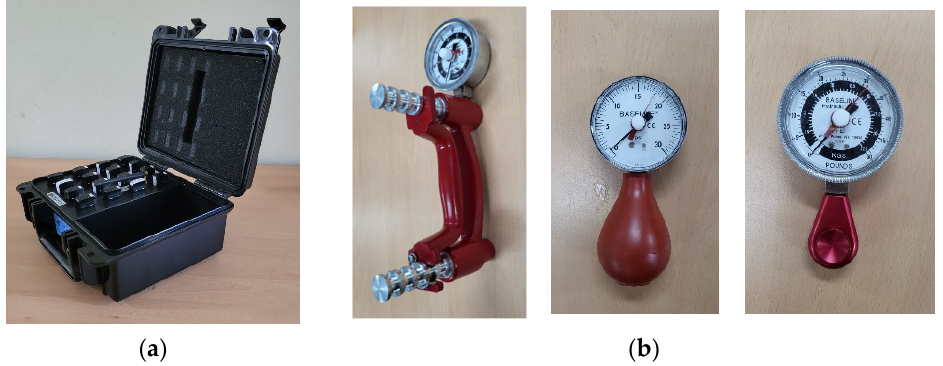
Figure 1. Experimental equipment: ( a ) multichannel sEMG system, ( b ) hand dynamometers.